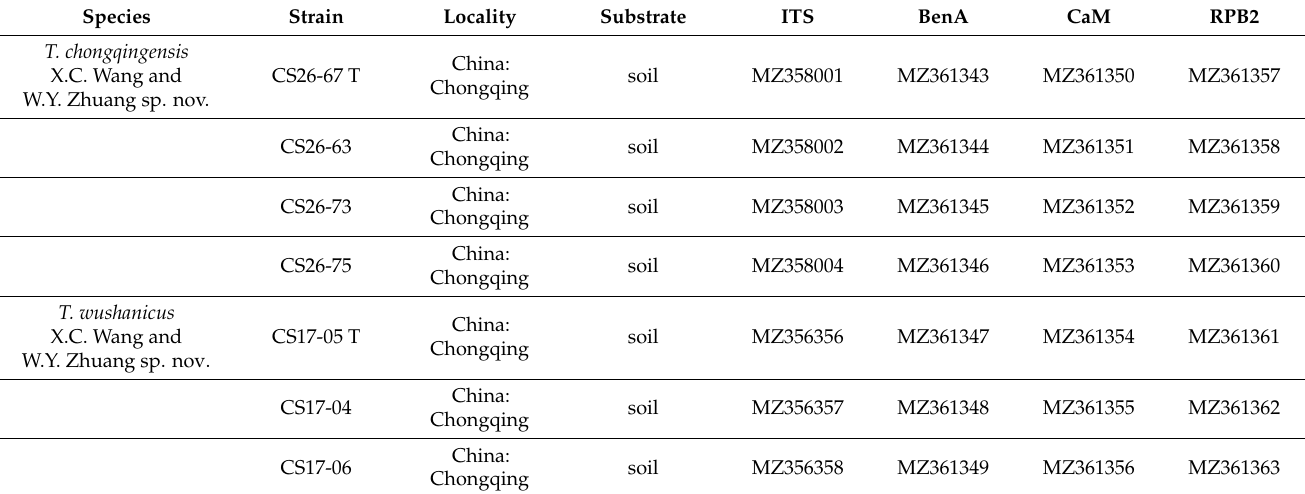
Table 3. New species and newly generated sequences reported in this study.